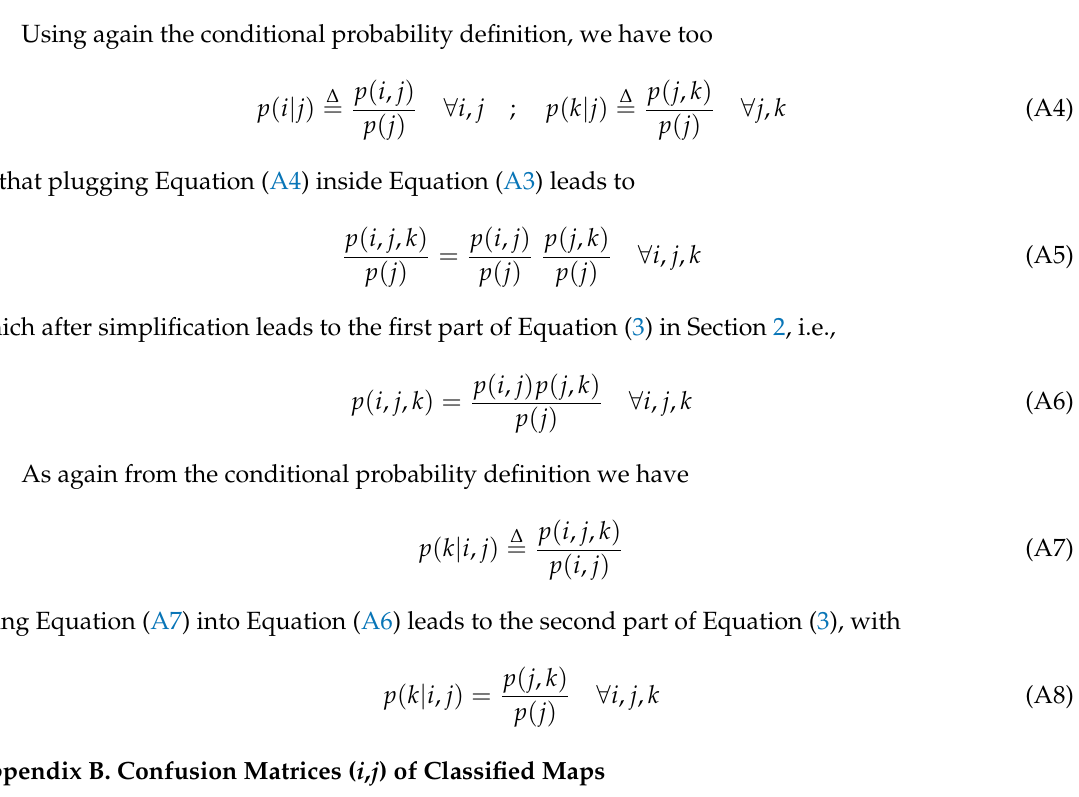
Table A1. Confusion matrix with case study errors and medium overall accuracy.